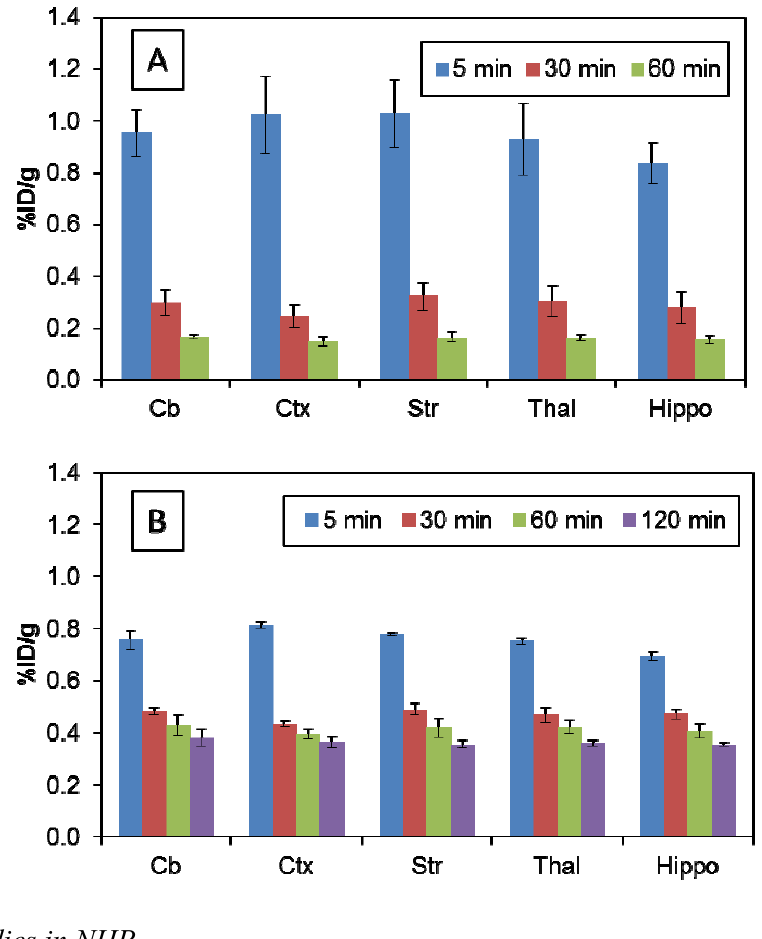
Figure 2. Regional radioactivity uptake in male Sprague Dawley (SD) rat brain ( n = 4). ( A ) Regional brain uptake of [ 11 C] 2a ; ( B ) regional brain uptake of [ 18 F] 2b . Cb, cerebellum; Ctx, cortex; Str, striatum; Thal, thalamus; Hippo,